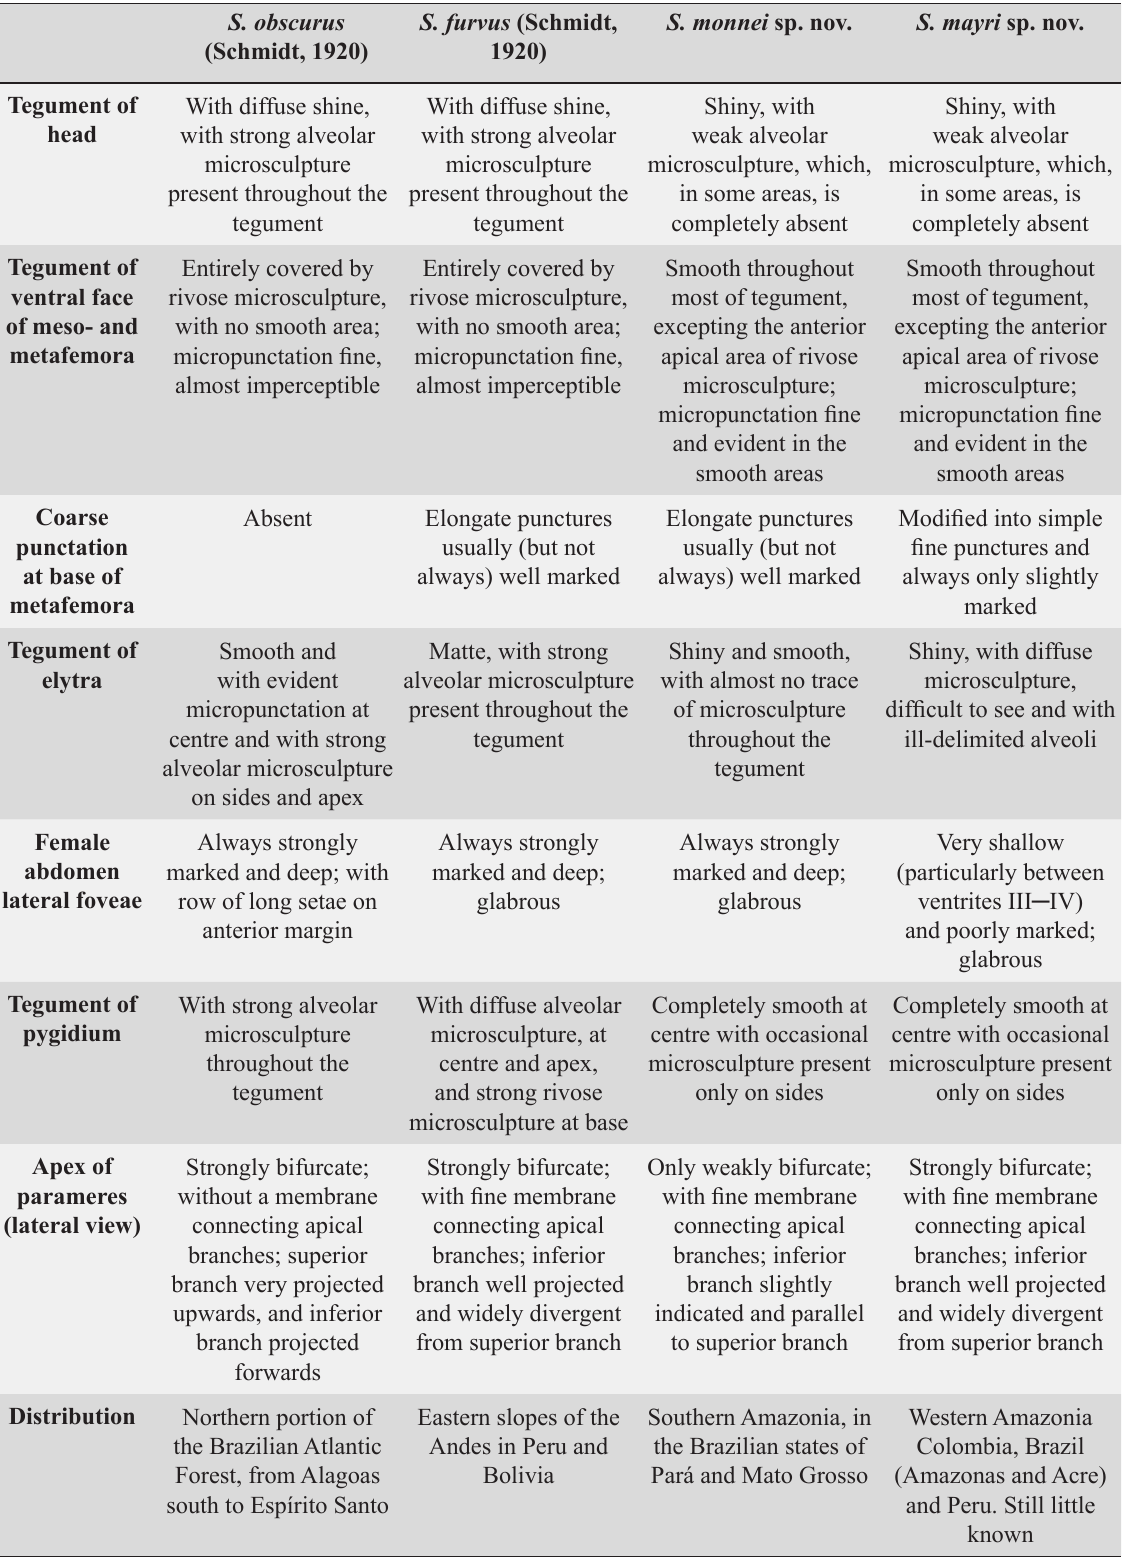
Table 5. Summary of the morphological and distributional differences between the four species of the furvus